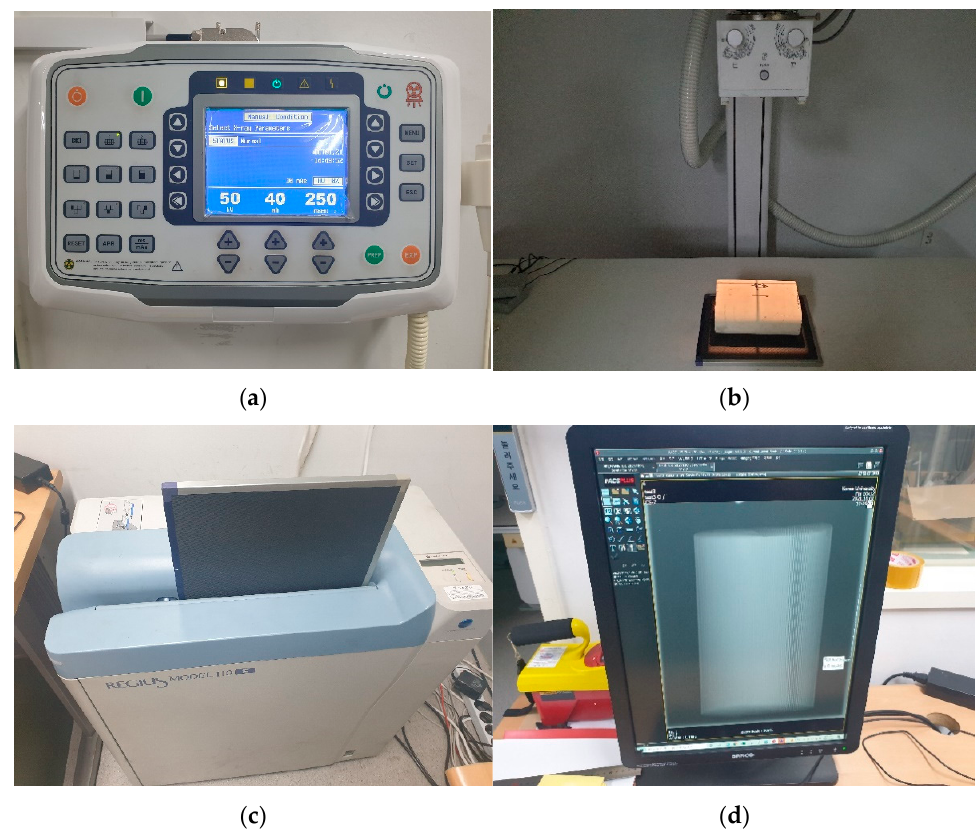
Figure 6. X-ray experimental setup photos: ( a ) tube voltage and tube current setting; ( b ) taking an X-ray; ( c ) insert IP into CR reader; ( d ) image output to the computer. Table 4. The establishment of irradiation